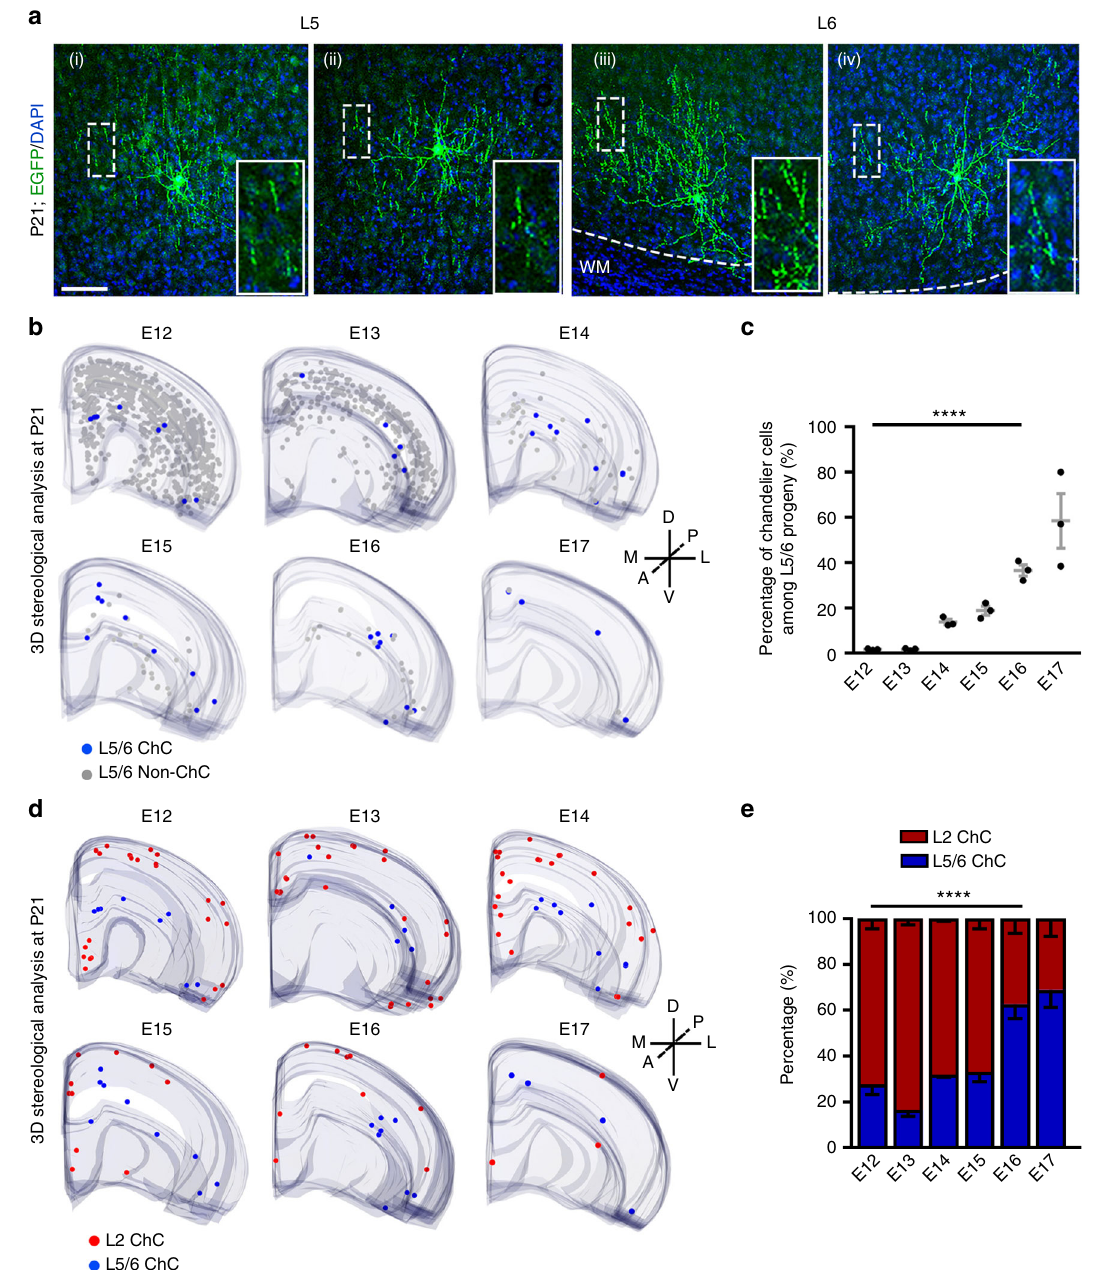
Fig. 5 Late outside-in neurogenesis by NKX2.1 + MGE/PoA RGPs generates deep layer chandelier cells. a Images of P21 neocortices that received in utero EGFP-expressing retrovirus injection, stained for EGFP (green), and counterstained with DAPI (blue). EGFP-expressing chandelier cells were found in layers 5 (left two cells) and 6 (right two cells). High magni fi cation images of the vertical arrays of axonal cartridges characteristic of the chandelier cell (broken rectangles) are shown in the insets. Broken lines represent the white matter (WM) boundary. Scale bar: 50 µ m. b 3D reconstruction images of the neocortical hemispheres showing EGFP-expressing chandelier cells and non-chandelier cells in layers 5/6. Blue and gray dots represent the cell bodies of L5/6 chandelier and non-chandelier cells, respectively. c Percentage of chandelier cells among EGFP-expressing interneurons in layers 5/6. Gray lines represent mean ± SEM. Black dots represent individual brains ( n = 3 per time point). **** P < 0.0001 (one-way ANOVA). d 3D reconstruction images of the neocortical hemispheres showing EGFP-expressing chandelier cells in layers 2 and 5/6. Red and blue dots represent the cell bodies of EGFP-expressing chandelier cells in the super fi cial layer 2 and deep layers 5/6, respectively. A anterior, P posterior, D dorsal; V ventral, M medial, L lateral. e Ratios of EGFP- expressing chandelier cells in the super fi cial layer 2 and deep layers 5/6. **** P < 0.0001 (one-way